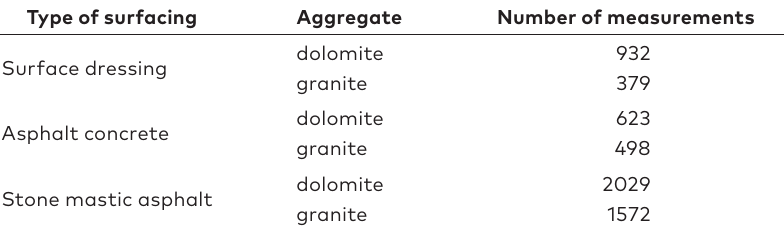
Table 1. Data of skid resistance measurements